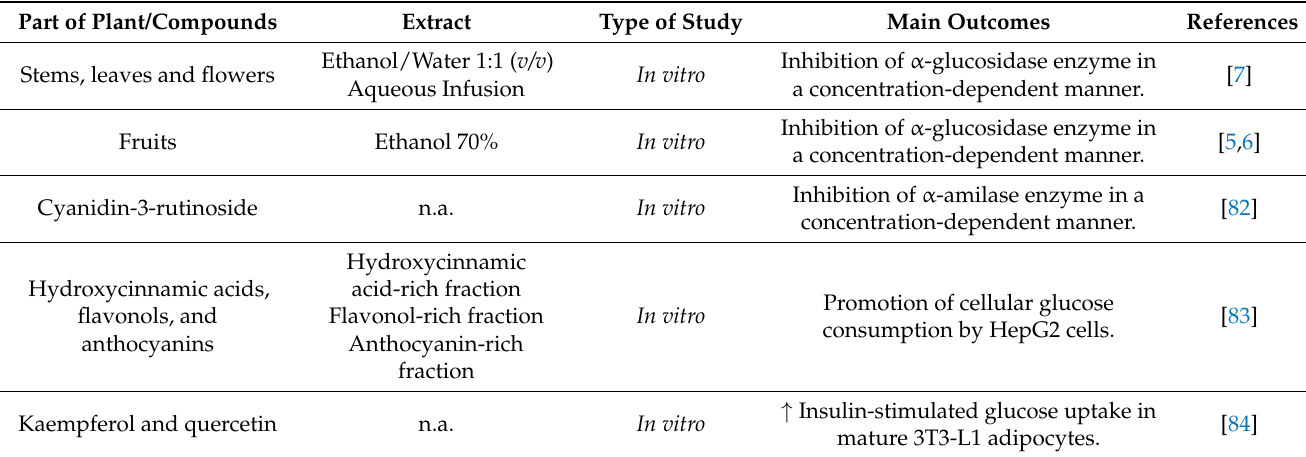
Table 5. Anti-hyperglycemic activity of Prunus avium L. fruits and